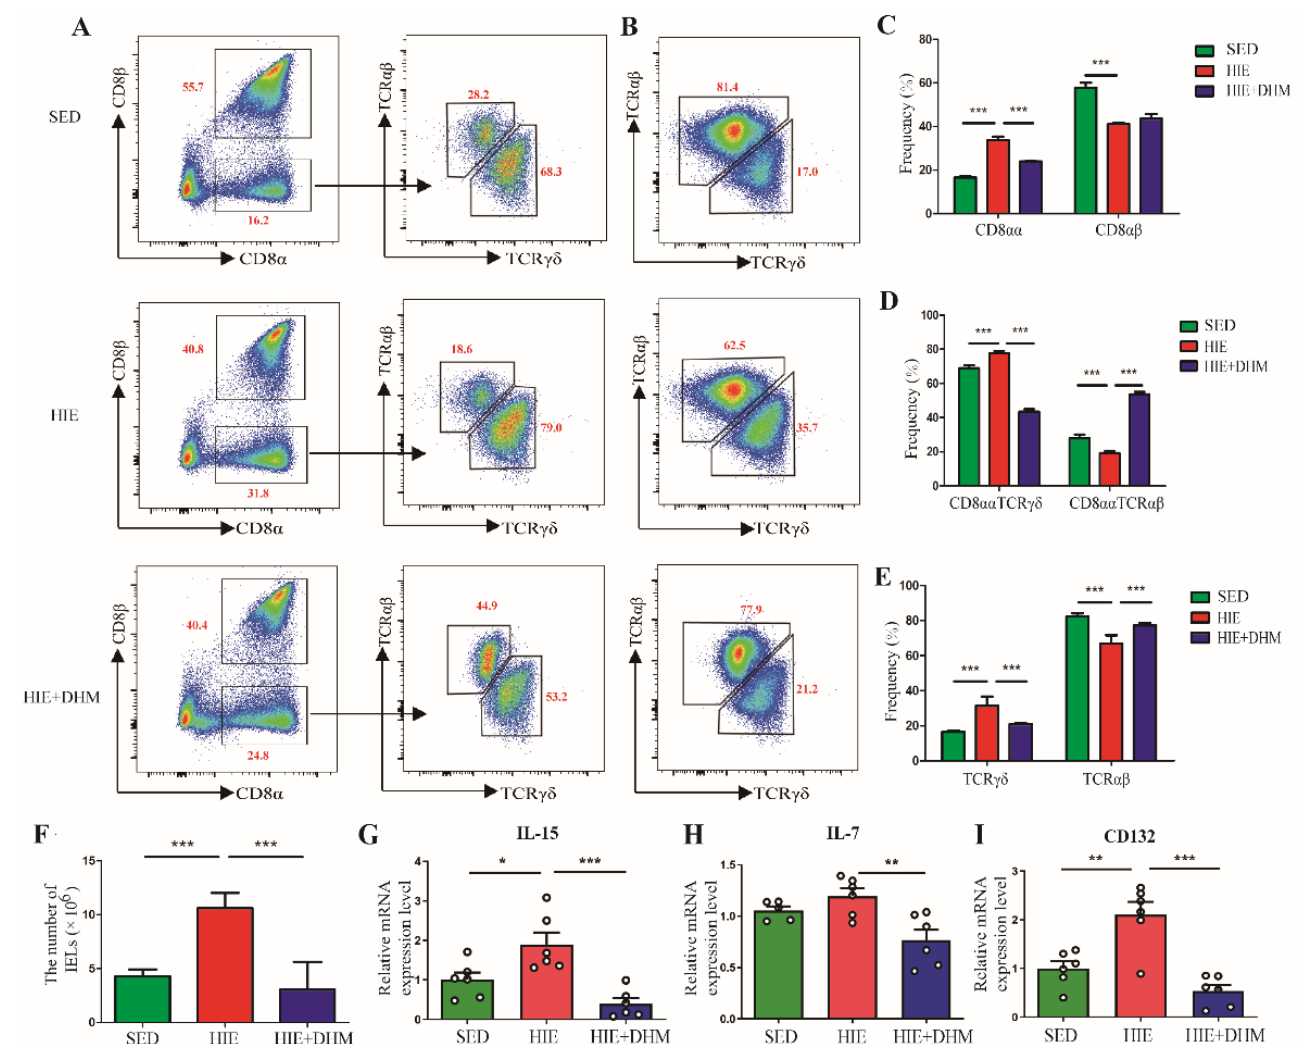
Figure 3. DHM reduces the number of IELs and the frequency of CD8 αα + IELs in mice following high-intensity exercise. ( A , B ) The IELs from the small intestine of mice were stained as indicated. Cell populations with the frequency of gated cells were shown by different cell phenotype markers (cells were gated by CD3 + ) ( n = 5). ( C ) The frequencies of CD8 αα and CD8 αβ on CD3 + IELs cell populations among three groups were shown. Cells were stained with anti-CD3, anti-CD8 α and anti-CD8 β mAbs and positively gated by CD3 ( n = 5). ( D ) The frequencies of CD8 αα TCR αβ and CD8 αα TCR γδ on CD3 + IELs cell populations among three groups were shown. Cells were stained with anti-CD3, anti-CD8 α , and anti-CD8 β , anti-TCR αβ , and anti-TCR γδ mAbs and positively gated by CD3 ( n = 5). ( E ) The frequencies of TCR αβ and TCR γδ on CD3 + IELs cell populations among three groups were shown. Cells were stained with anti-CD3, anti-TCR αβ , and anti-TCR γδ mAbs and positively gated by CD3 ( n = 5). ( F ) The number of IELs in the small intestine among three groups were shown ( n = 5). ( G – I ) The mRNA expression levels of IL-15 ( G ), IL-7 ( H ) and CD132 ( I ) in the small intestine tissues were assessed by qRT-PCR assay ( n = 5–6). Data were expressed as means ± SEM. The experiments were replicated 2-3 times. The data shown were from one representative experiment, * p < 0.05, ** p < 0.01 and *** p < 0.001. Multiple groups were tested by one-way ANOVA followed by Bonferroni’s post hoc test.